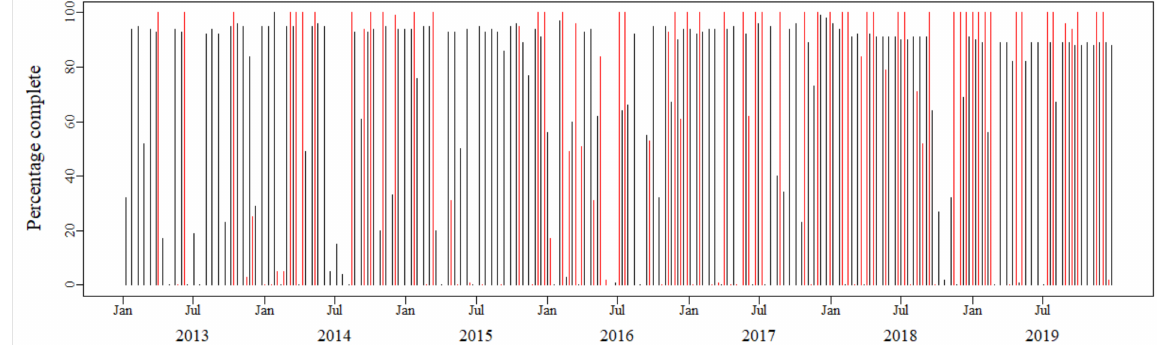
Figure 2. Percentage completeness of available Landsat-7 (black) and Landsat-8 (red) images for the period 2013 to 2019.